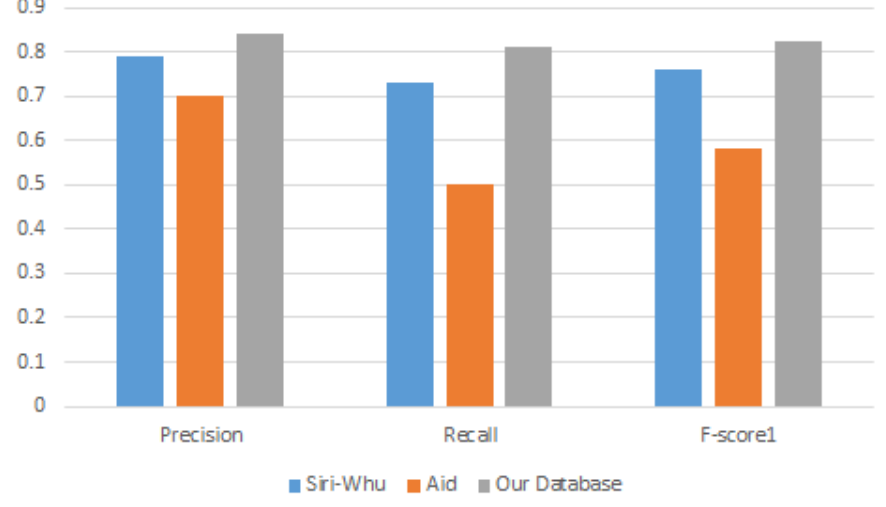
Figure 9. Results of our approach with VGGNet on Siri-Whu, Aid and our